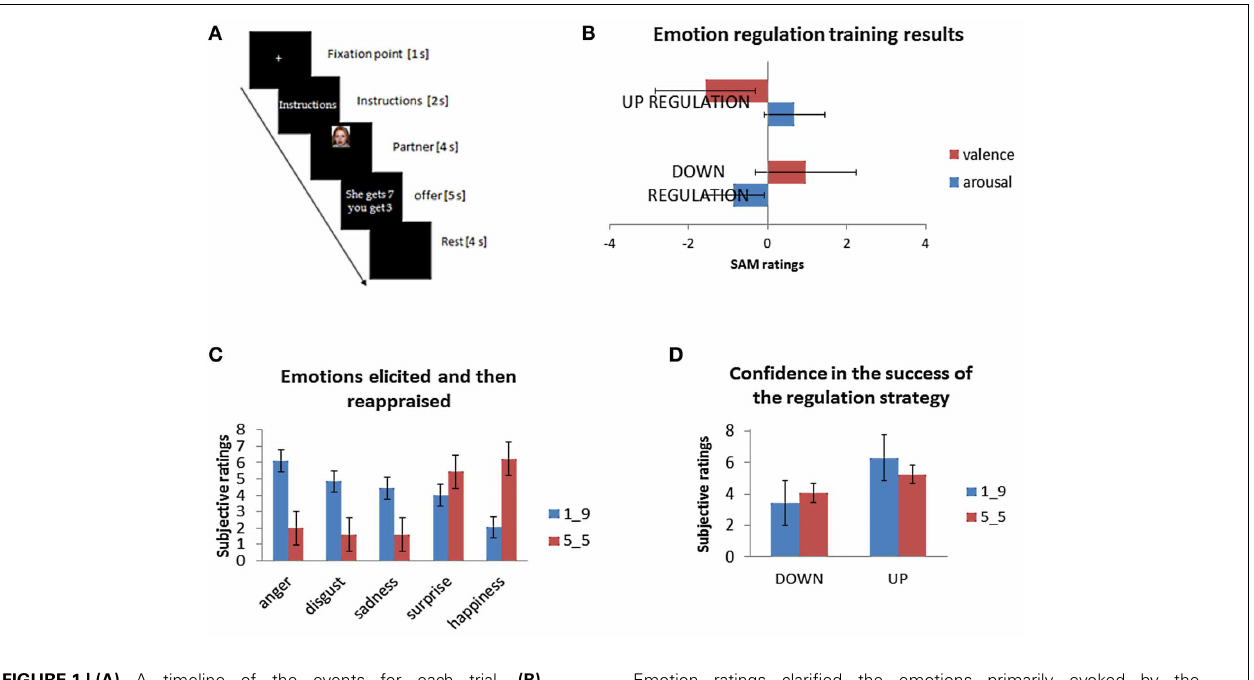
Emotion ratings clarified the emotions primarily evoked by the task. (D) Subjects reported their emotions changing according to both